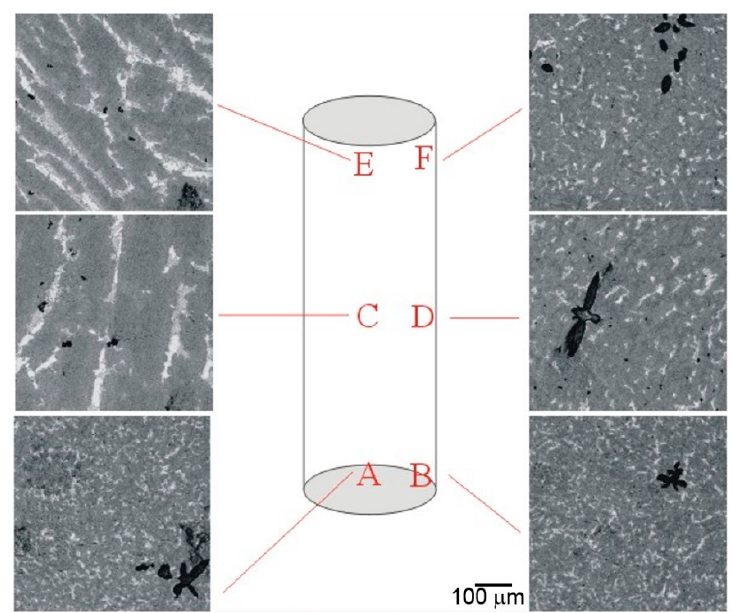
Figure 3. Scanning Electron Microscope (SEM) cross-section micrographs showing the microstructures from various locations of a 100-kg AB 2 ingot with a composition of Ti 9 Zr 26.2 V 5 Cr 3.5 Mn 15.6 Co 1.5 Ni 38 Sn 0.8 Al 0.4 prepared by VIM. The electrochemical discharge capacities of ingots from locations A, B, C, D, E, and F are 390, 400, 391, 402, 389, and 397 mAh·g − 1 with a discharge current density of 8 mA·g − 1 . The dark, white, and gray regions are ZrO 2 inclusions, secondary phases (TiNi, ZrNi, Zr 7 Ni 10 , and Zr 9 Ni 11 ), and main C14 phases, respectively.